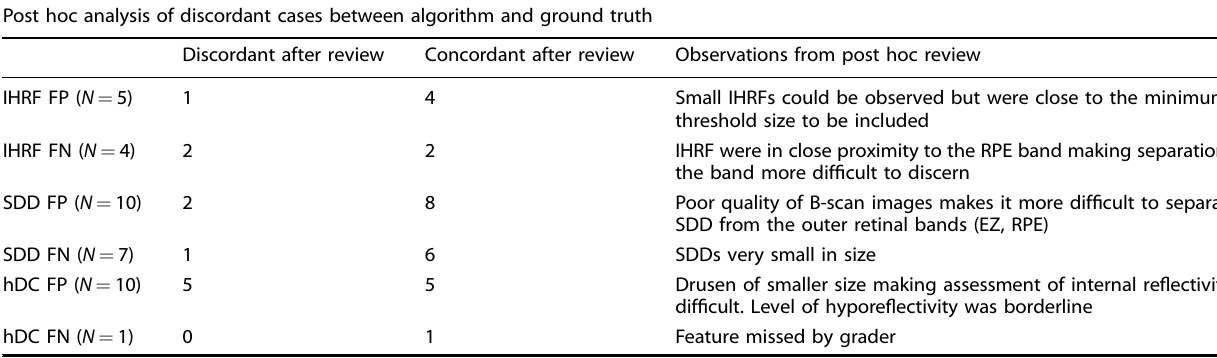
Table 1. Discordant cases were reviewed by a senior retina specialist grader